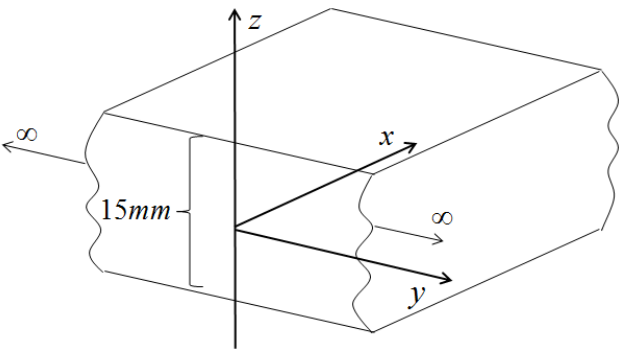
Figure 1. Semi-analytical finite element (SAFE) model of wave propagating in plate.